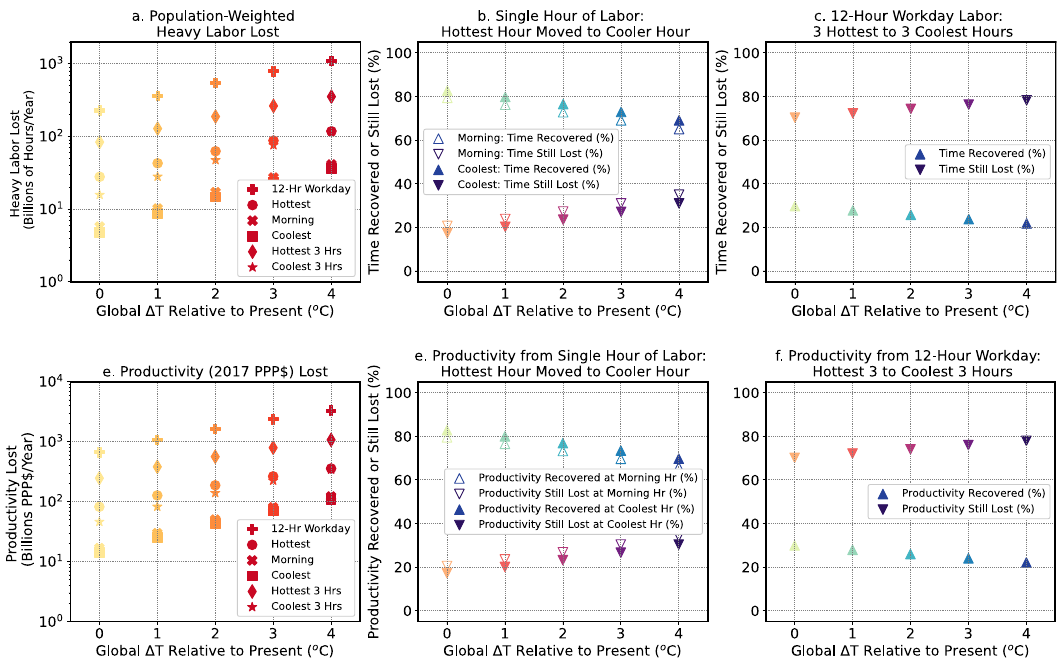
Fig. 4 Global heavy labor and productivity losses and reduced global adaptation potential with warming. Global sums of population-weighted heavy labor lost ( a – c ), and productivity (purchasing power parity-adjusted international dollars, or 2017 PPP$) lost ( d – f ) for global-mean temperature changes (Global Δ T ) relative to the recent past (2001-2020) of + 1 °C, + 2 °C, + 3 °C, and + 4 °C. Global sums of heavy labor lost ( a ) and productivity lost ( d ) weighted by working-age population in heavy labor ( “ Methods ” ) for the full 12-h workday, the hottest hour of the day, a morning hour (the third coolest hour of the day), the coolest hour of the day, the 3 hottest hours of the day, and the 3 coolest hours of the day. Percent of time ( b ) or productivity ( e ) that can be recovered (or is still lost) by moving labor from the hottest single hour of the day to the morning hour (un fi lled triangles) or to the coolest hour of the day around sunrise ( fi lled triangles). Percent of lost work time ( c ) or productivity lost ( f ) in the 12-h workday that can be recovered if work in the 3 hottest hours of the day is replaced with work in the 3 coolest hours of the day. Note the log y-axis scale for the left panels showing global sums of labor or productivity lost. Productivity is shown in units of 2017 PPP$ equivalent ( “ Methods ” ; Supplementary Text